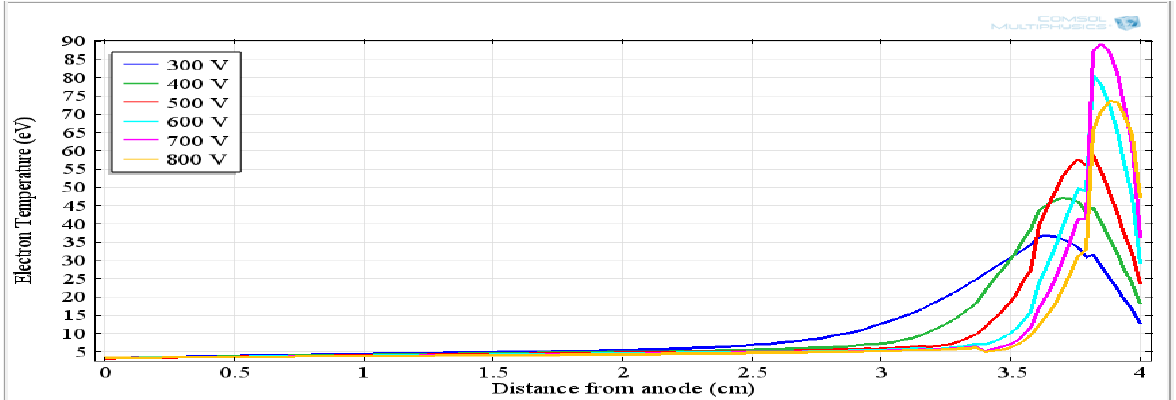
Fig. 8: Electron temperature as a function distance from anode at different discharge voltages.